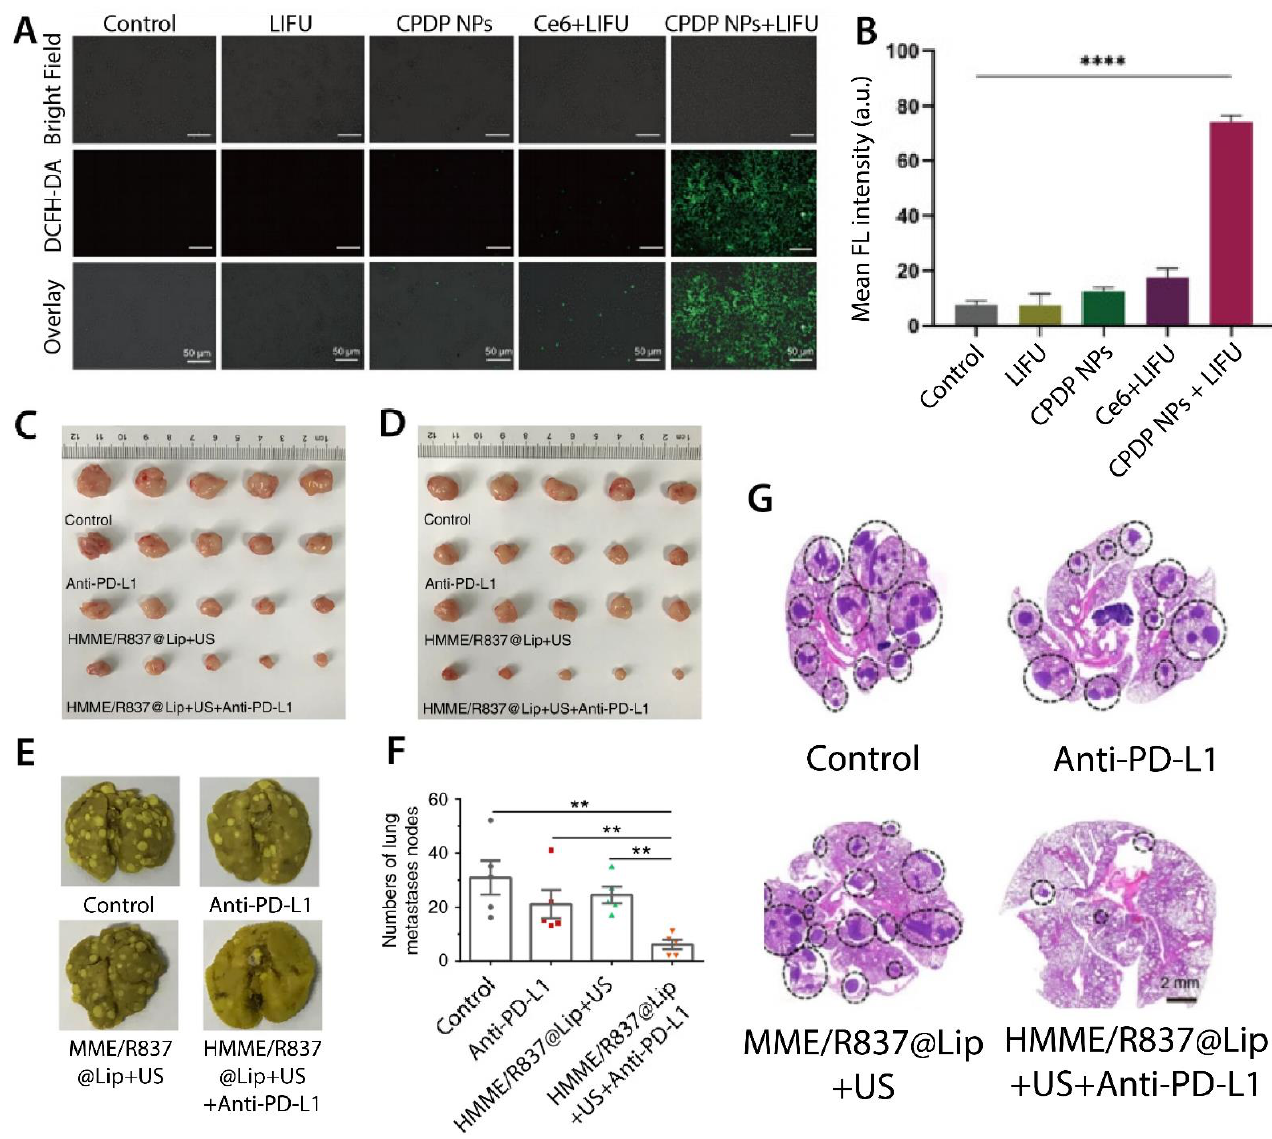
Figure 9. The efficiency of different ultrasound-responsive NPs against lung cancer. ( A ) Confocal laser scanning microscopy images of ROS generation in CPDP NPs + LIFU, Ce6 + LIFU, CPDP NPs, and LIFU treatments (scale bars; 50 µ m); and ( B ) FL intensity analysis of these groups (****p < 0.0001, n = 3) [112]. ( C ) Photograph of primary tumors treated with HMME/R837@Lip + US + Anti-PD-L1, HMME/R837@Lip + US, and Anti-PD-L1 and ( D ) distant tumors in mice treated with these NPs. ( E ) Photograph of metastatic nodules in mice in different groups and ( F ) the number of metastatic tumors in the lung counted under the microscope (** p < 0.01). ( G ) Histological examination of lung metastasis in different groups (hematoxylin and eosin) [114].